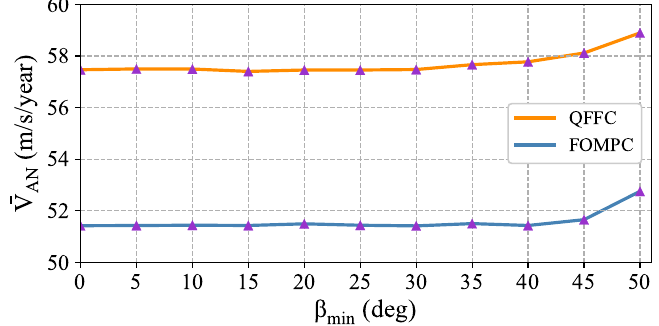
Figure 10. The results of Monte Carlo simulations for β min .